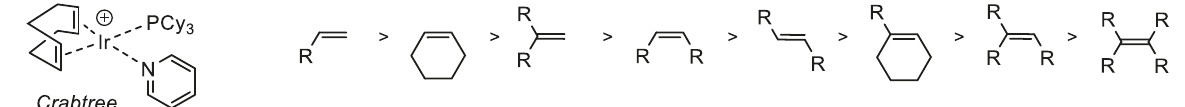
Fig. 1 Catalytic alkene hydrogenation. The Crabtree catalyst and the general rate order in alkene hydrogenation 52 . Activation of the C = C bond by conjugation with alkenes or arenes facilitates